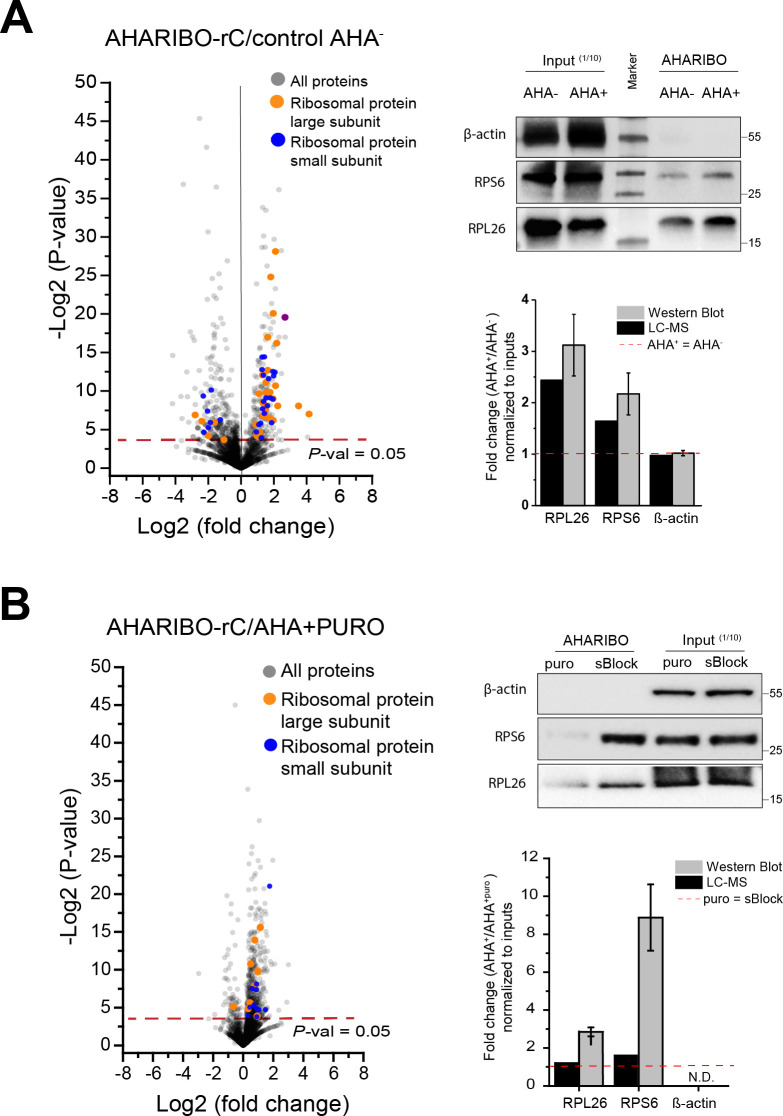
Liquid chromatography-mass spectrometry (LC-MS) analysis of AHARIBO-rC proteins and validation by western blot.Volcano plots showing the -Log (p-value) versus the relative abundance of AHARIBO-rC-isolated proteins. Data are compared with the non-specific signal derived from streptavidin-coated beads incubated with lysates from control (AHA-, without L-azidohomoalanine) (A) and puromycin-treated cells (without sBlock). Red broken line indicates threshold p-value<0.05. (B) Western blots of RPL26, RPS6, and actin with related quantifications of band intensities are reported on the right of each dot blot. AHARIBO: AHA-mediated RIBOsome isolation.